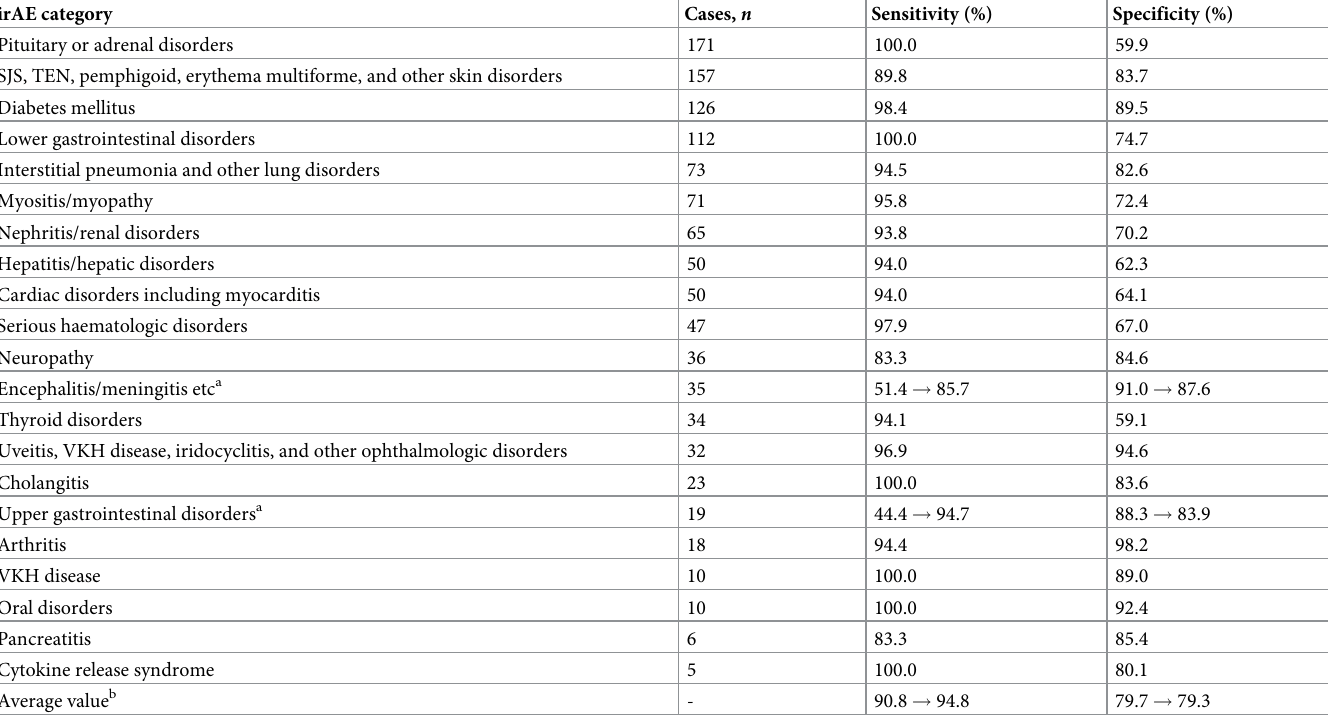
Table 3. Sensitivity and specificity of the application for predicting